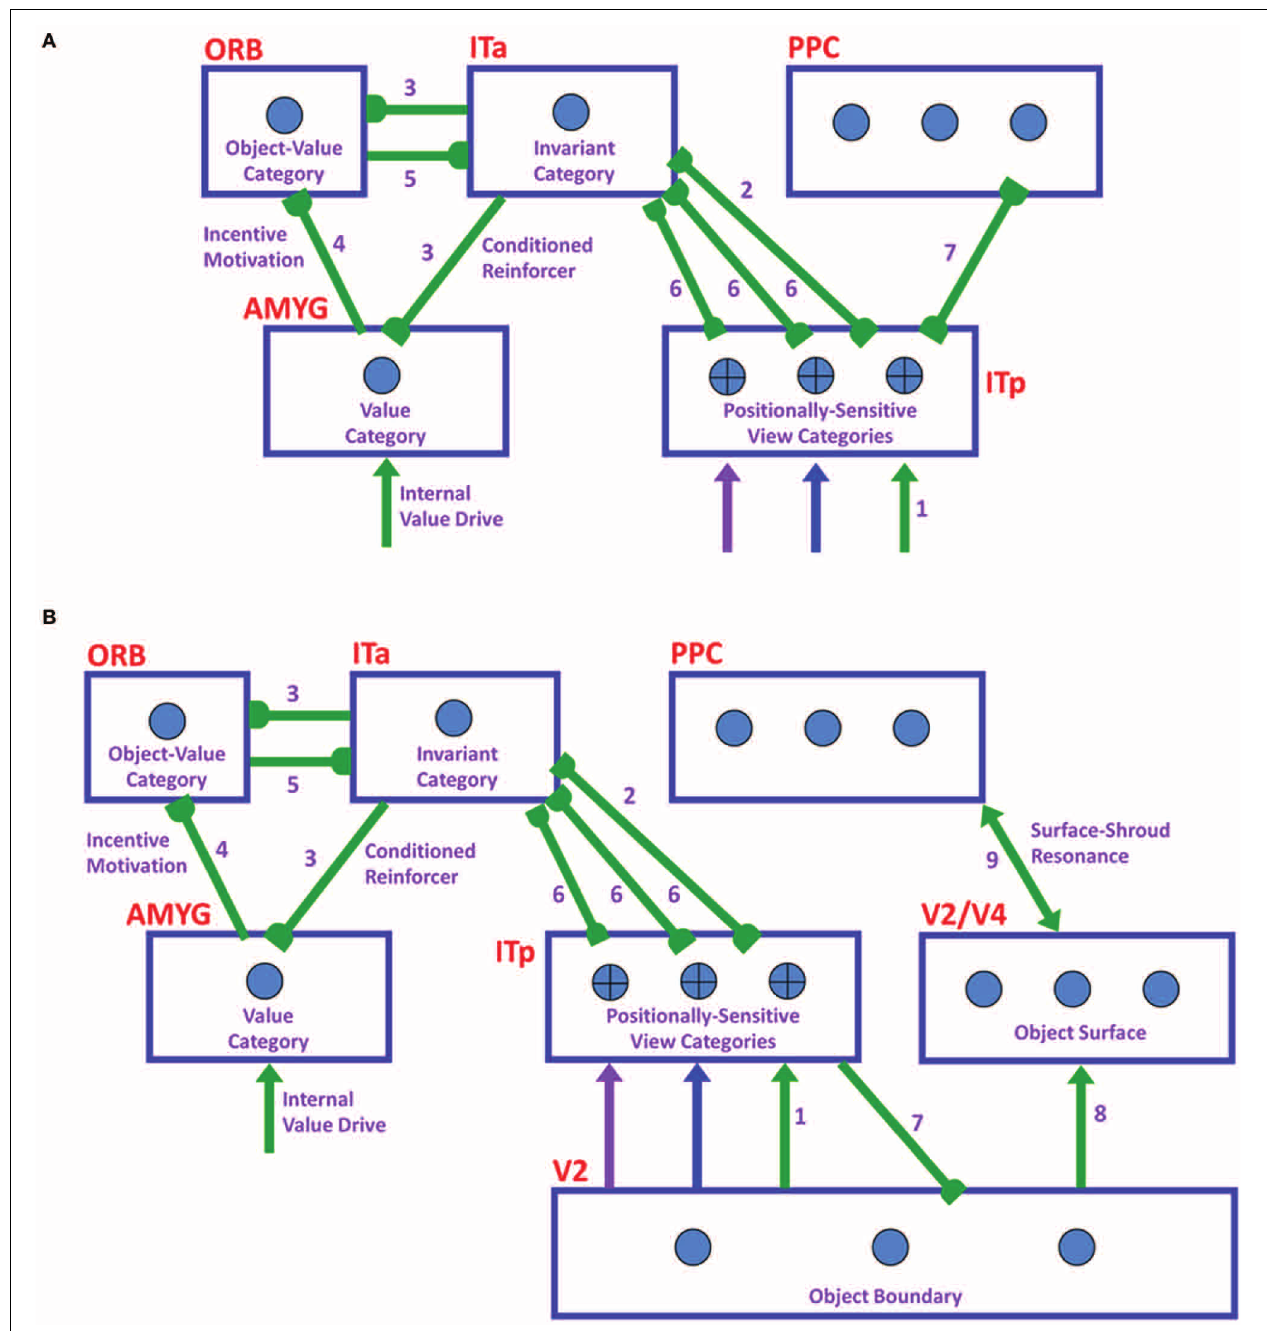
FIGURE 5 | Bottom-up stimulus-driven What stream recognition to Where stream search and action through (A) a direct What-to-Where pathway and (B) an indirect What-to-Where pathway. Interactions between multiple brain regions, such as ITa, ITp, amygdale, and orbitofrontal